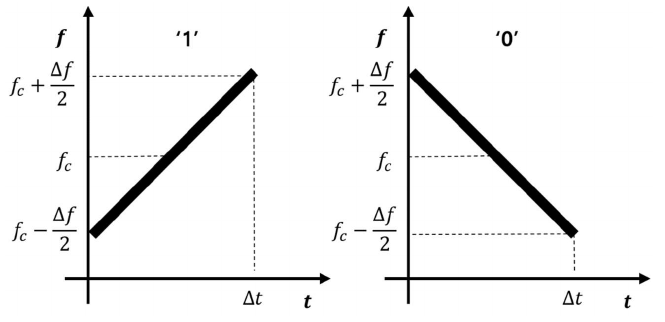
Figure 1. Frequency sweep keying.